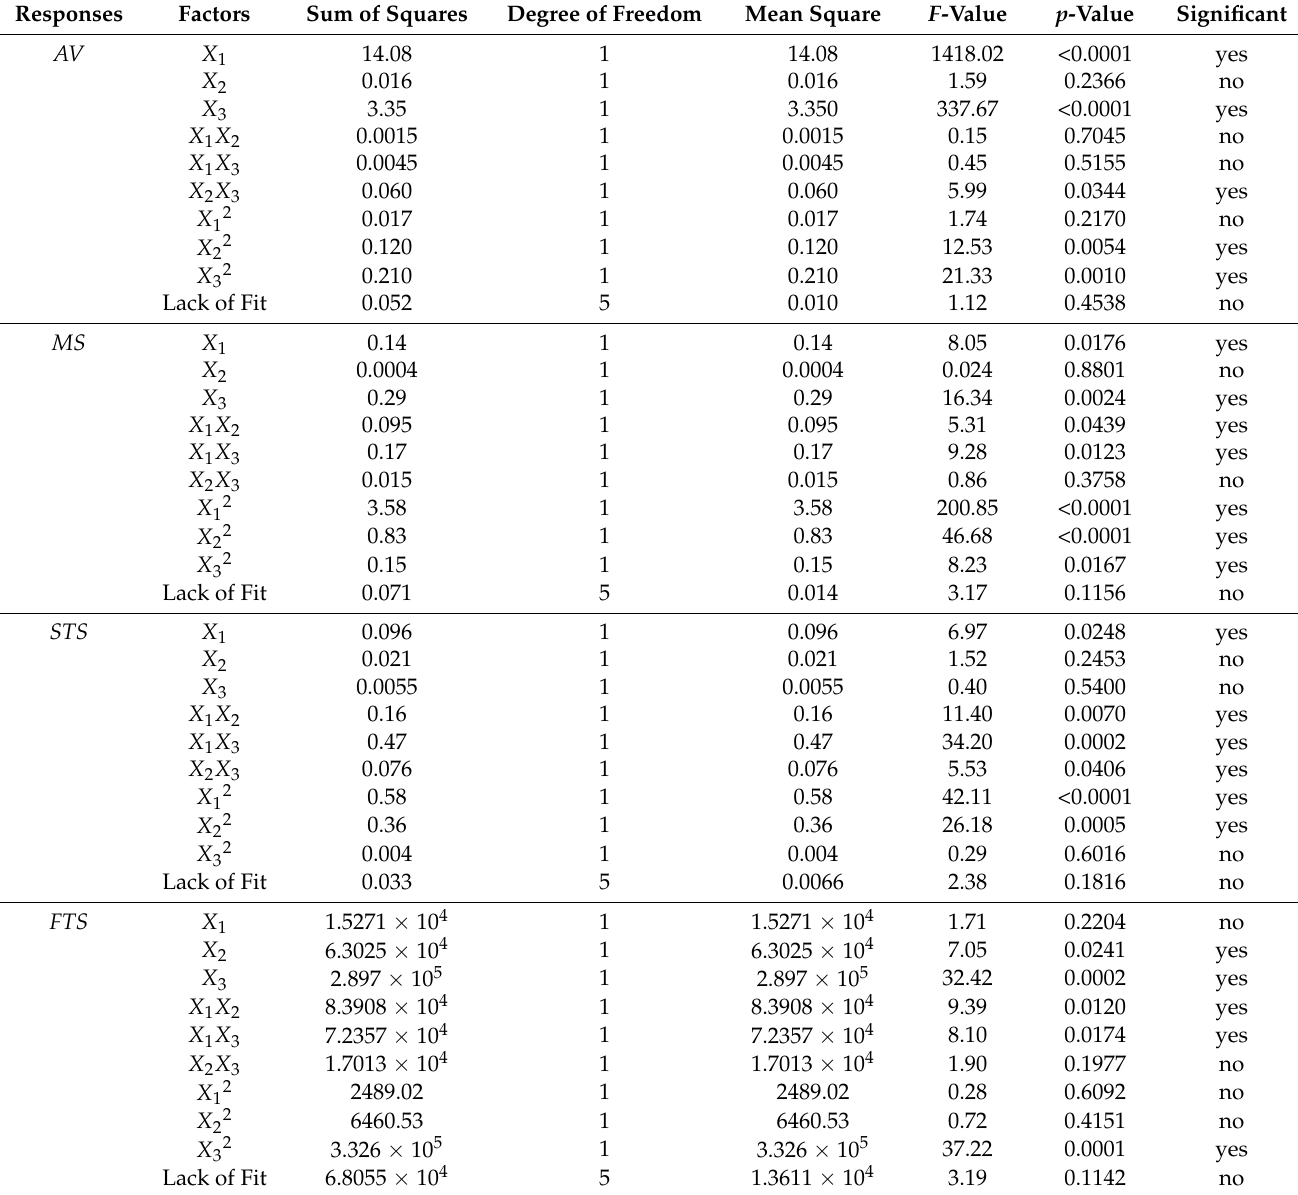
Table 9. ANOVA results for independent